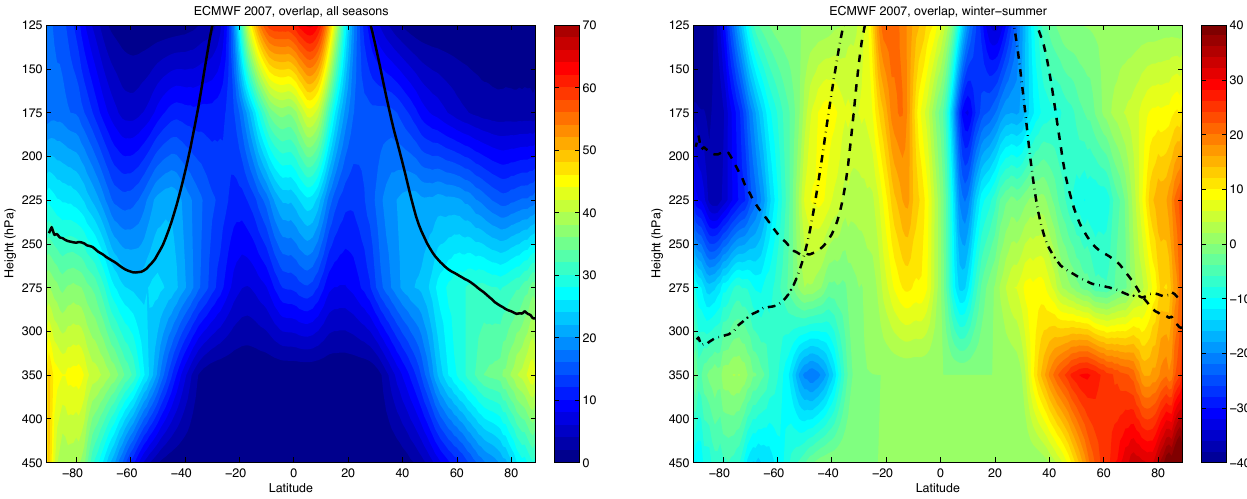
Fig. 17. Zonal means of ice supersaturation occurrence frequencies (%) from ECMWF (“layer supersaturation” scheme) for the year 2007 (left) along with boreal winter minus boreal summer differences (right). Plain line: zonal-mean tropopause (all seasons). Dashed line: zonal mean summer tropopause. Pointed dashed line: zonal mean winter tropopause.